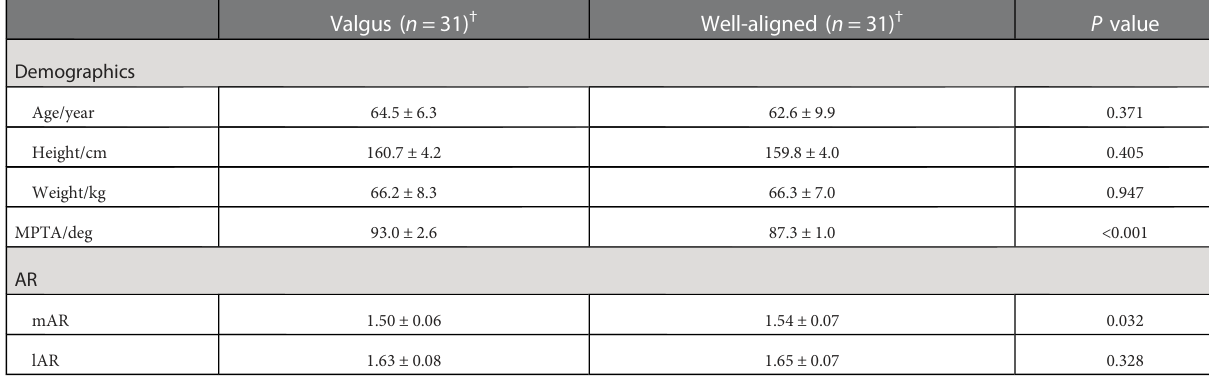
TABLE 1 Aspect ratios of resected tibial surface with different tibial